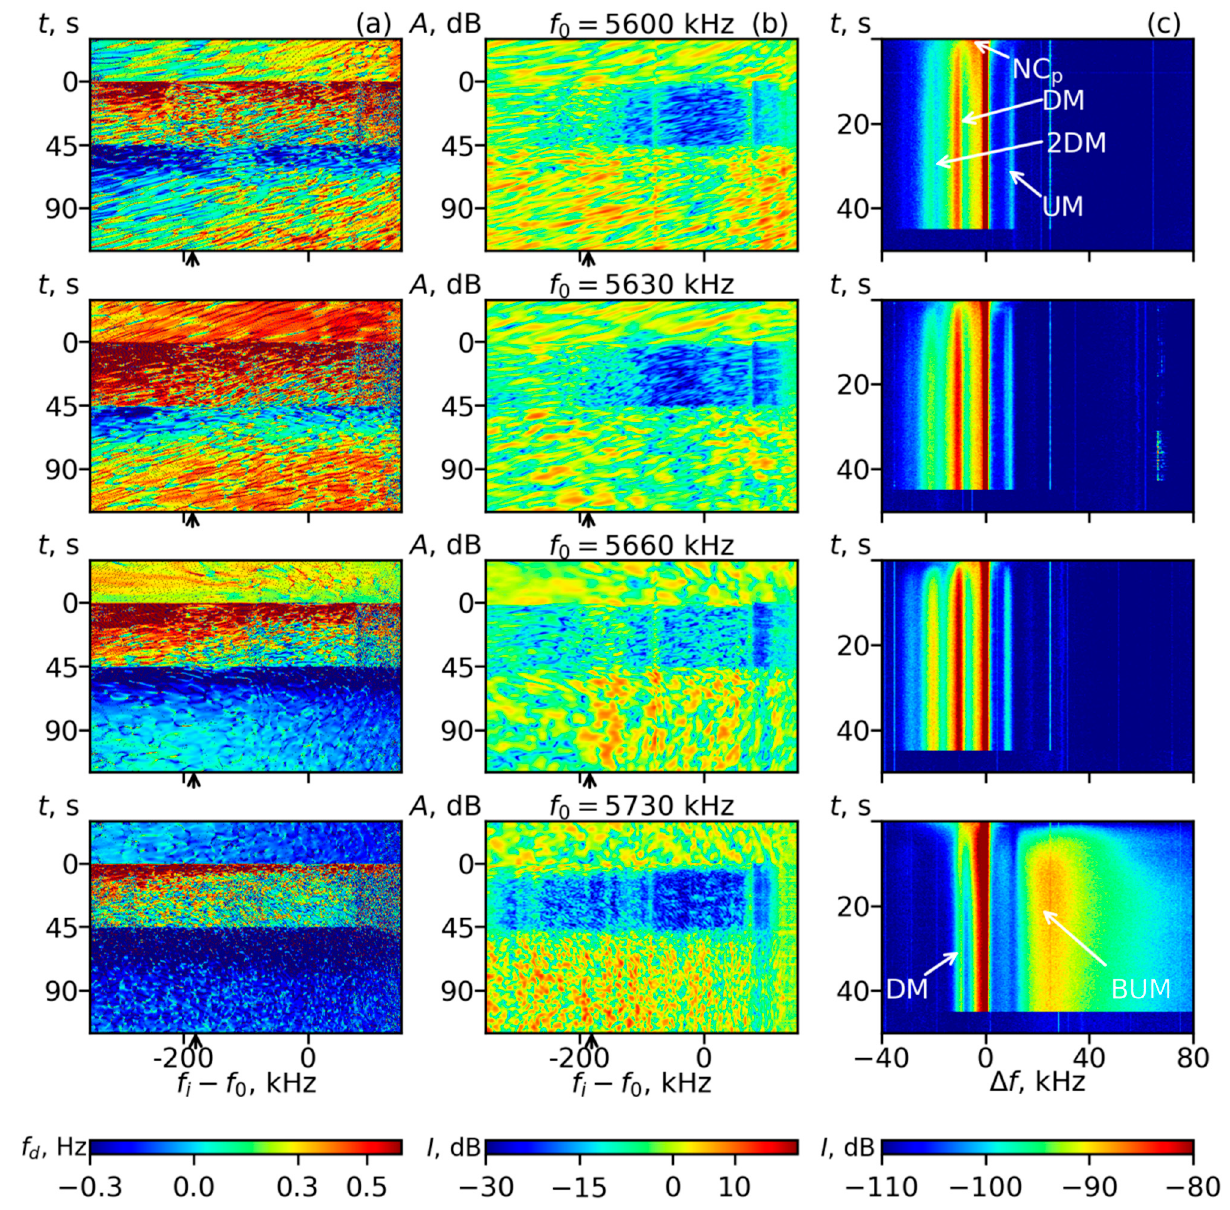
Figure 3. Data that were obtained in the cycles for the PW reflection heights z r0 ≲ 220 km. The PW frequencies f 0 are shown above the ( b ) panels. Column ( a ): The Doppler frequency shifts (colors) vs. time t and diagnostic wave spectral component frequency shift f i – f 0 . Column ( b ): Normalized amplitude of the diagnostic waves G (color) vs. t and frequency shift f i – f 0 . Column ( c ): The SEE spectrograms. Prominent SEE spectral features, i.e., the NC p , DM, 2DM, UM and BUM, are marked.